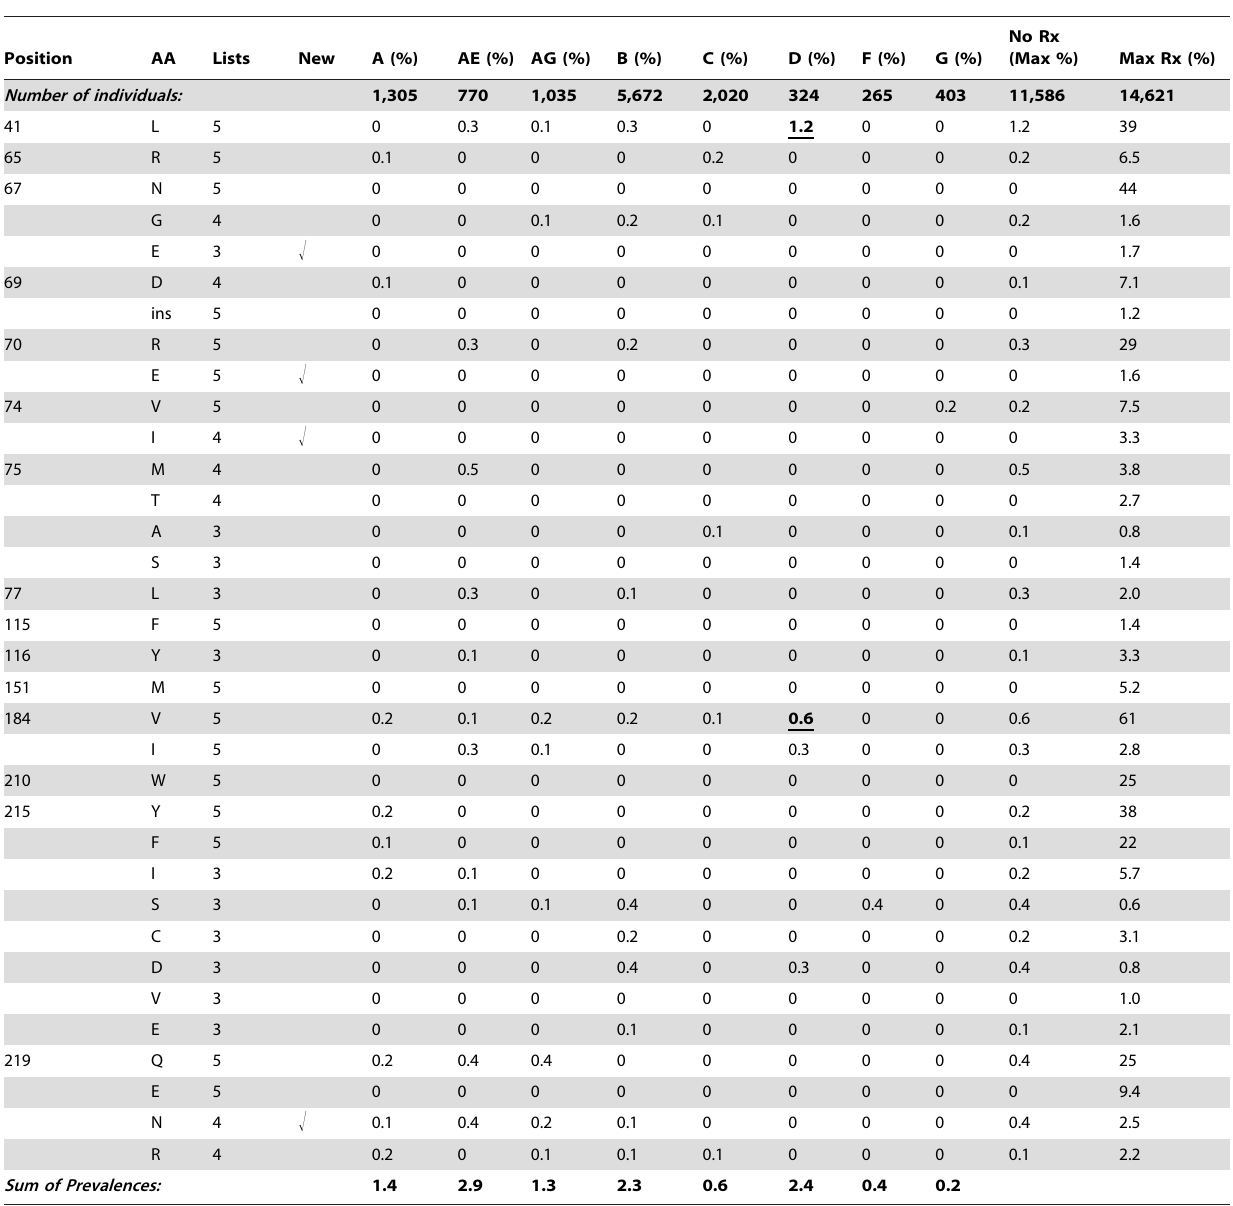
Table 2. Nucleoside RT Inhibitor Surveillance Drug Resistance Mutation (SDRM) List: 34 Mutations at 15 Positions